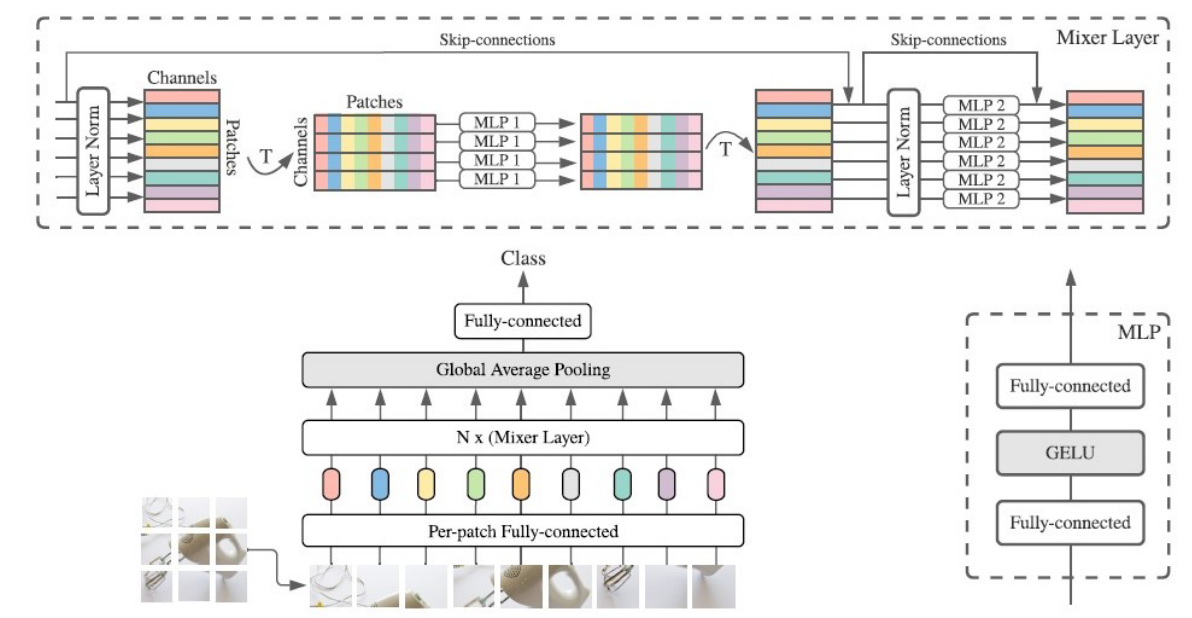
Figure. 1 . The architecture of the MLP-Mixer. Per-patch linear embeddings, Mixer layers, and a classifier head comprise MLP-Mixer. One token-mixing MLP and one channel-mixing MLP, each with two fully connected layers and a GELU nonlinearity, are present in the mixer layers. Other features are skip-connections, dropout, and channel layer norm (Tolstikhin et al.,